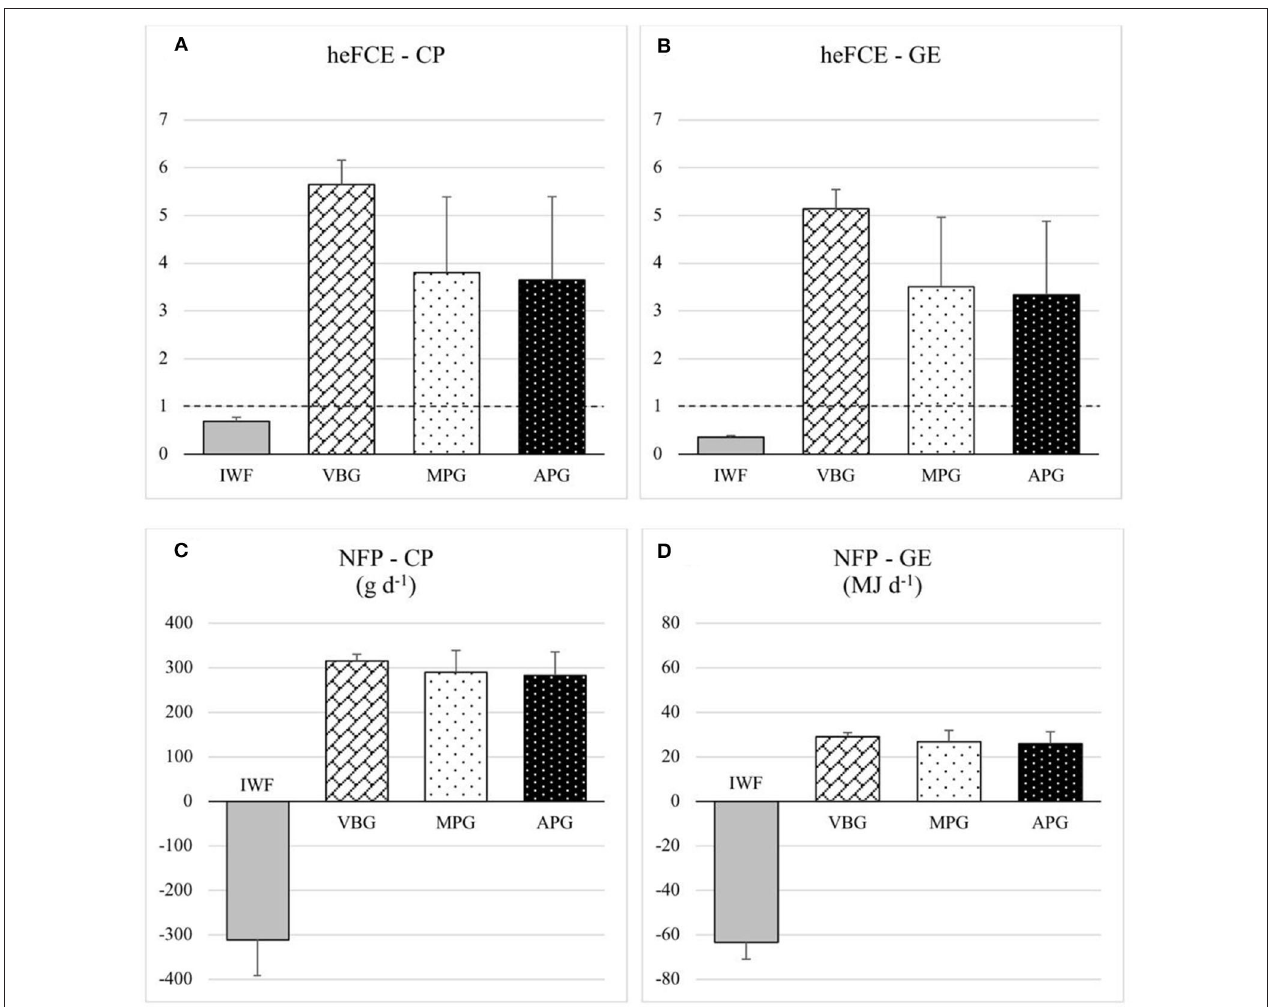
FIGURE 4 | Human-edible feed conversion efficiency - heFCE (A,B) and net food production - NFP (C,D) for crude protein (CP) and gross energy (GE) comparing the four scenarios (IWF, Indoor Winter Feeding; VBG, Valley Bottom Grazing; MPG, Mountain Pasture Grazing; APG, Alpine Pasture Grazing); the dashed line in (A) and (B) set at 1.0 indicates the efficiency threshold.